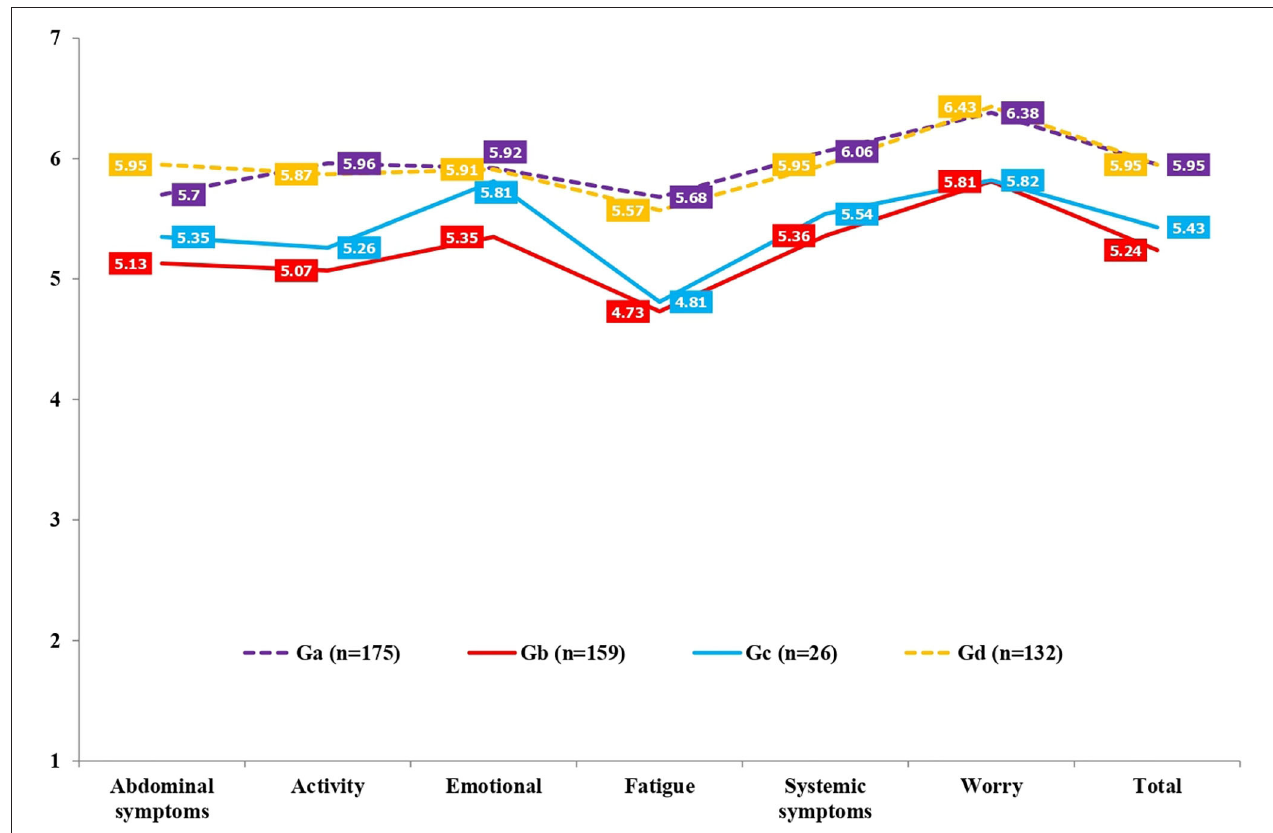
FIGURE 4 | Comparison of quality of life (CLDQ-NAFLD) in non-alcoholic fatty liver disease (NAFLD) severity groups. G a , no-NASH without significant fibrosis; G b , NASH with significant fibrosis; G c , no-NASH with significant fibrosis; G d , NASH without significant fibrosis; NASH , non-alcoholic steatohepatitis; CLDQ-NAFLD